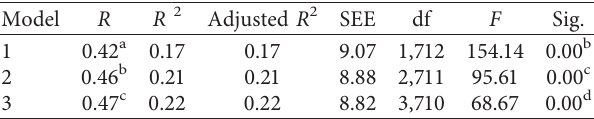
N � 714. a Predictors: (constant), school type-dummy. b Predictors: (con- stant), school type-dummy, academic efficacy. c Predictors: (constant), school type-dummy, academic efficacy, age (15–17)